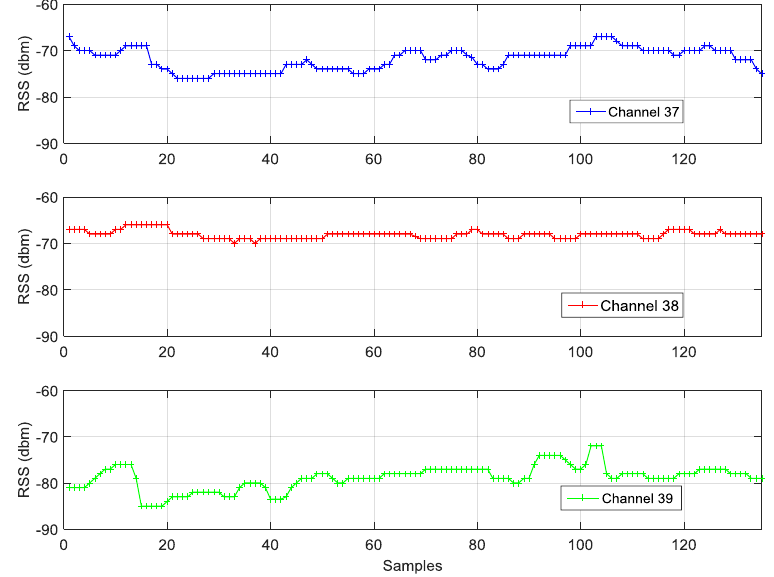
Figure 1. RSS values received from three advertisement channels by keeping the device static.